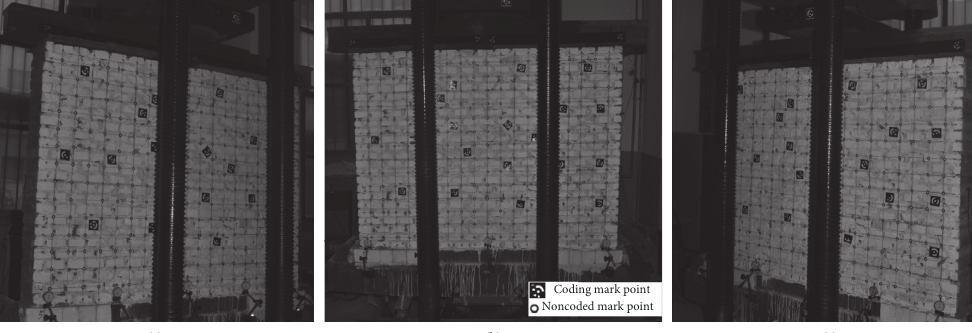
Figure 11: Experimental